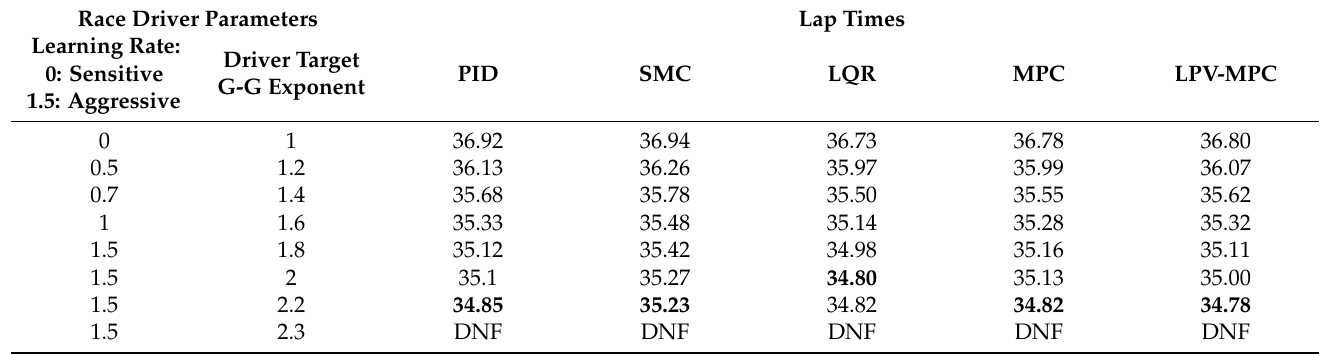
Table 7. Lap times at Olaberria.